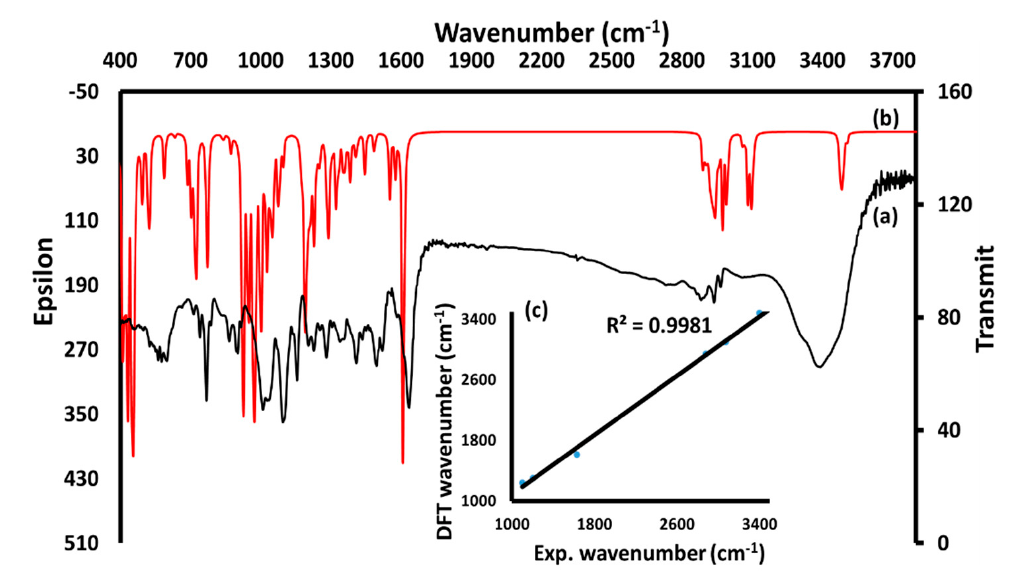
Figure 6. ( a ) Experimental solid-state IR, ( b ) Gaseous-state DFT-IR, and ( c ) Experimental DFT-IR correlation. The structure of GASB-1 was elucidated and confirmed by the data obtained from the 1 H NMR and 13 C-NMR spectra in DMSO-d6 presented in Figure 7a and Figure 7b, respectively. In the 1 HNMR, the spectra displayed several bands. The sugar protons were recorded at 2.5–5.5 ppm, the aromatic protons at 6.5–7.5 ppm, and the acidic phenolic proton and imine proton appeared at 13.20 ppm 8.25 ppm, respectively. In 13 C-NMR, the sugar carbons were detected in between 60–100 ppm, the aromatic carbons in between 115–135 ppm, and the imine and phenolic carbon signals appeared at 167.21 ppm and 160.99 ppm, respectively (see the experimental part). The protons and carbons NMR chemical shifts are consistent with the proposed structure solved by single-crystal